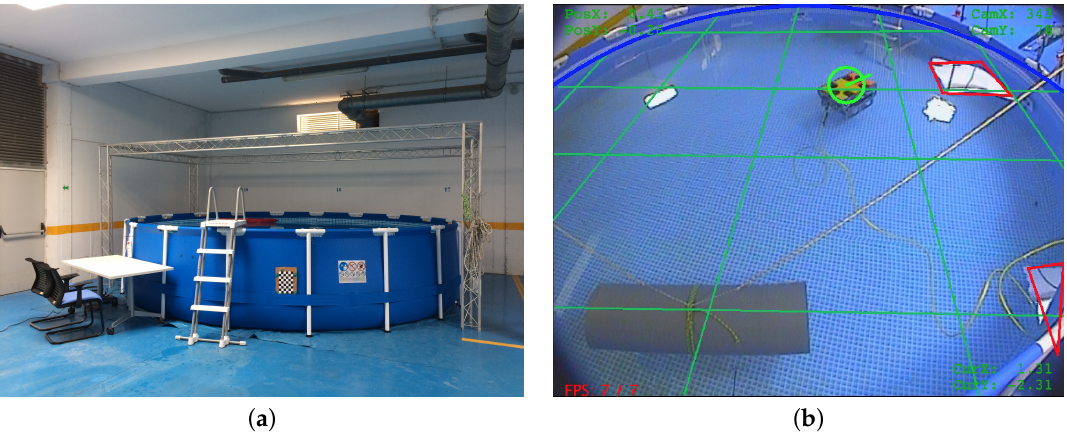
Figure 12. ( a ) Structured swimming pool scenario and ( b ) ground-truth estimation